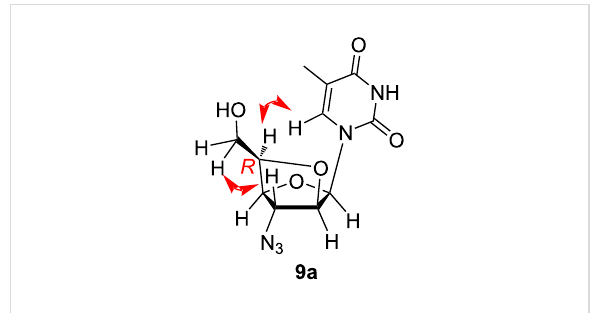
Figure 2: Structure elucidation of (5 ′ R )-3 ′ -azido-3 ′ -deoxy-2 ′ - O ,5 ′ - C - bridged- β - ᴅ -homoarabinofuranosylthymine ( 9a ).